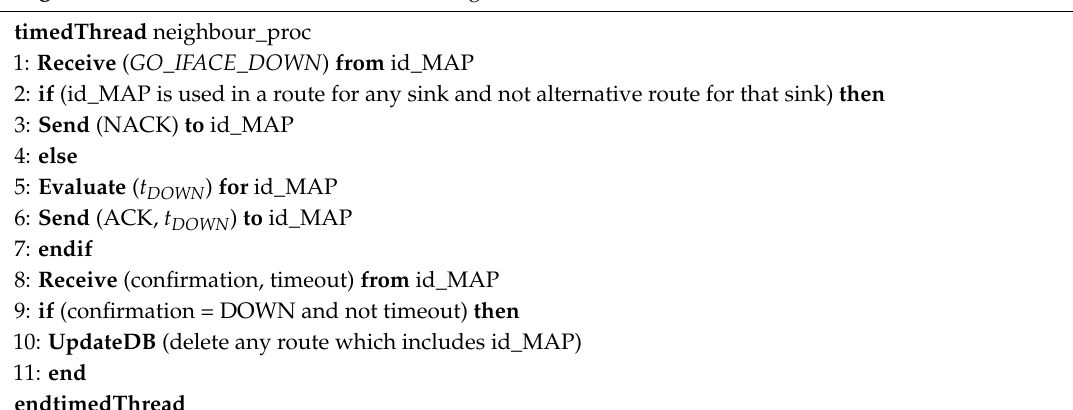
Algorithm 4: Basic Pseudocode of the dcr Neighbour_Proc